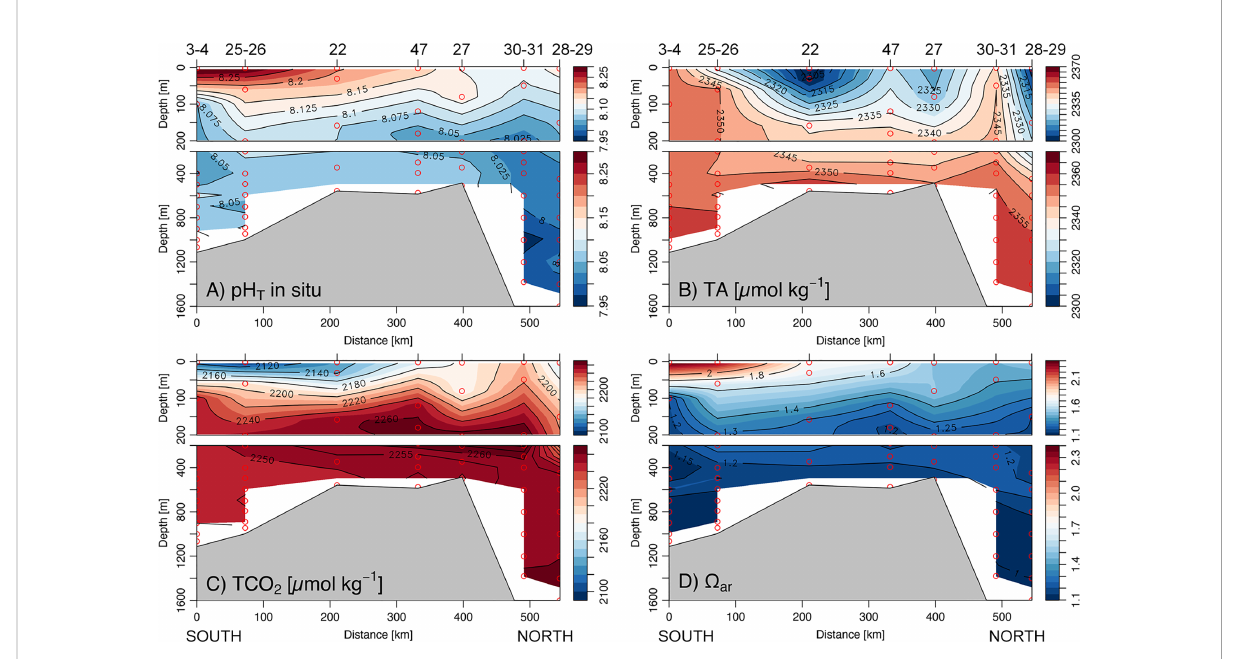
FIGURE 4 South-north vertical section across the Ross Sea (see Figure 1) for (A) pH T at in situ temperature (pH T in situ ), (B) total alkalinity concentration (TA; m mol kg − 1 ), (C) dissolved inorganic carbon concentration (TCO 2 ; m mol kg − 1 ), and (D) aragonite saturation state ( W ar